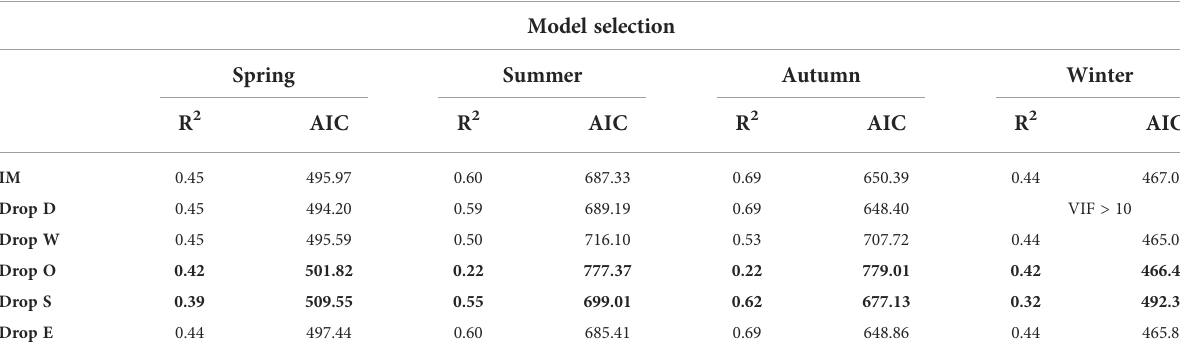
TABLE 4 Summary outputs of the multiple linear regressions. A backward stepwise model selection was performed based on R 2 and